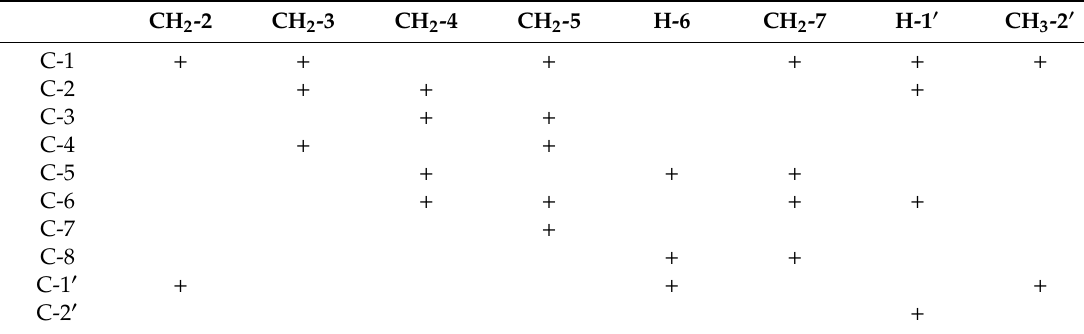
Table 1. Heteronuclear multiple-bond correlation—spectroscopy data of iodolactone 6